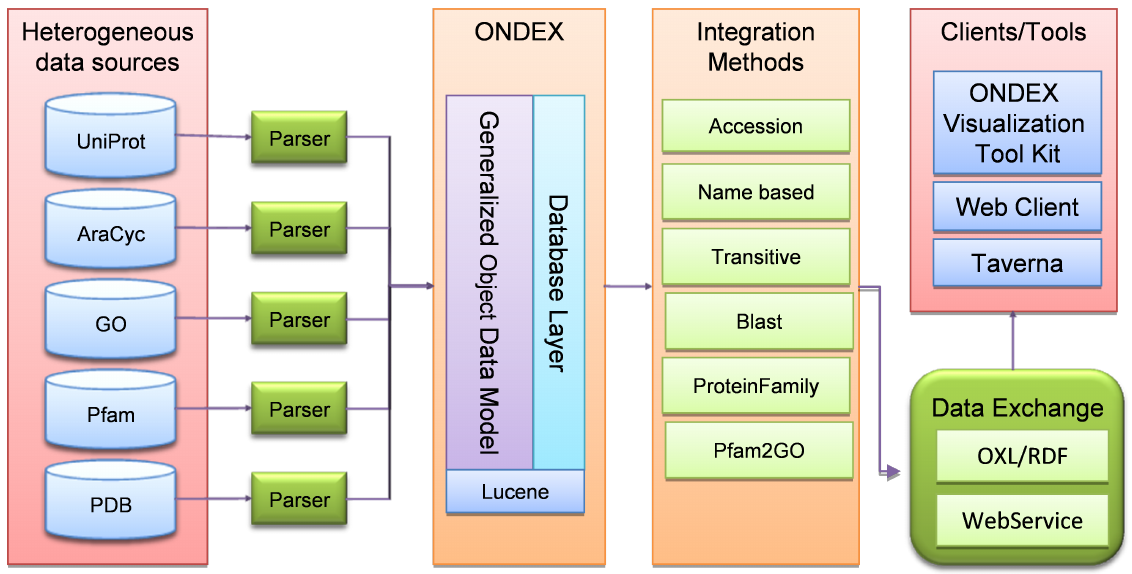
Figure 1: Overview of a typical ONDEX pipeline consisting of three parts: 1) parsing hetero- geneous data sources into the generalized object data model of ONDEX; 2) identifying equiva- lent and related entries and creating new relations between them using integration methods; 3) analysing the integrated data using client tools, e.g. the ONDEX Visualisation Tool Kit